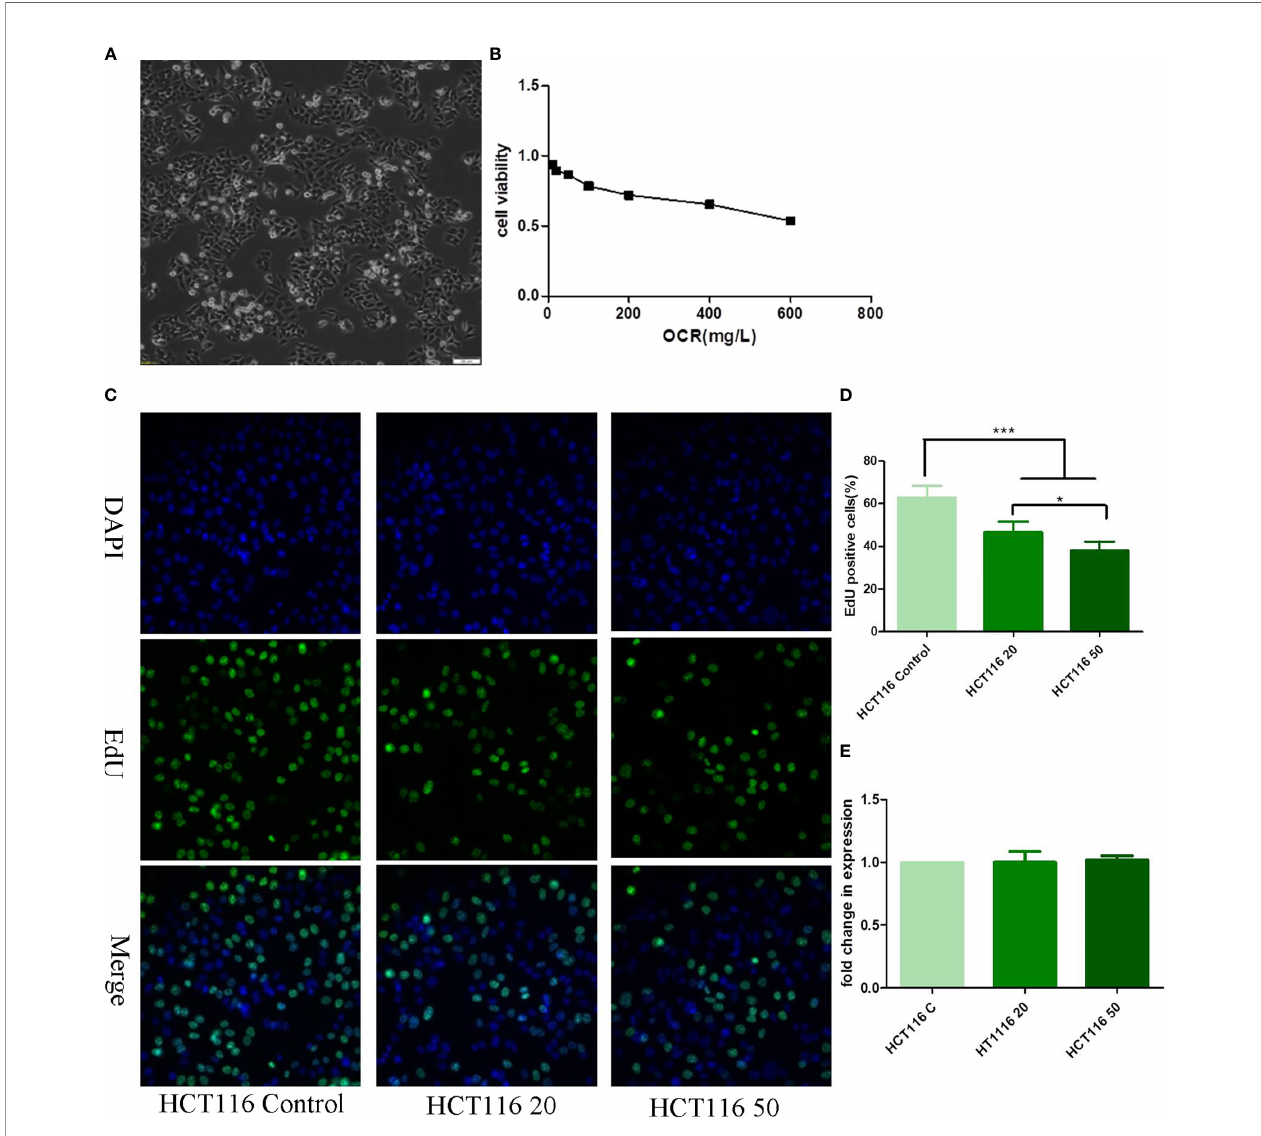
FIGURE 2 | The effects of essential oil from Curcumae rhizoma (CR) (OCR) on HCT116 cells. (A) HCT116 cell morphology. (B) The effects of different OCR concentrations on HCT116 viability. (C, D) The effects of OCR on HCT116 proliferation. (E) The effects of OCR on VEGFa mRNA expression in HCT116 cells. (n = 3, mean ± standard deviation (SD), ***P < 0.001, *P < 0.05 compared with the control